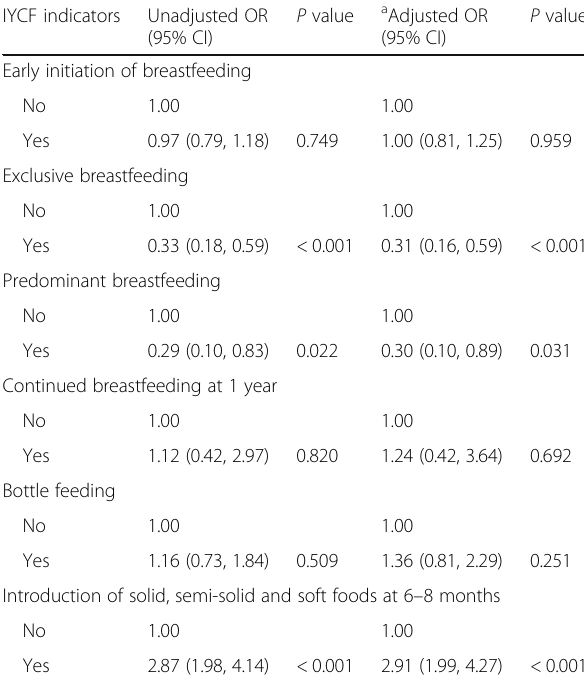
Table 3 Association between diarrhoea and infant and young child feeding (IYCF) indicators in Tanzania, TDHS 2010 IYCF